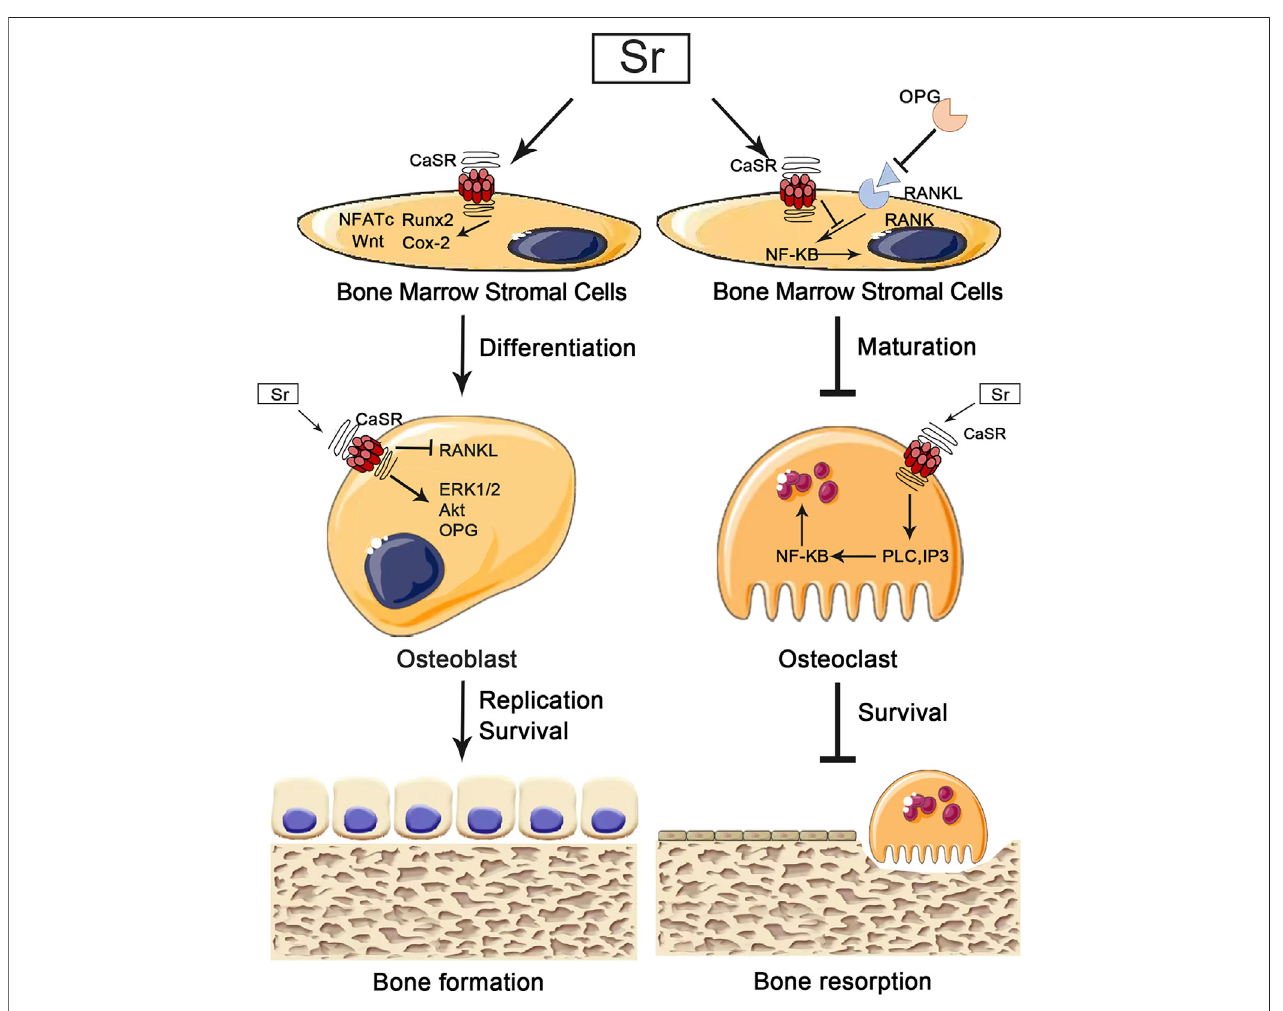
FIGURE2| Implicationsforthepharmacologicaleffectsofcalcium-sensingreceptors(CaSr)inosteoblastsandosteoclasts.Strontium(Sr)promotesosteogenesis by activating CaSr to instruct osteoblasts in downstream pathways that promote osteoblast differentiation, replication and survival. Sr also inhibits bone resorption by activating CaSR and to instruct osteoclasts in downstream pathways that inhibit osteoclast maturation and survival.